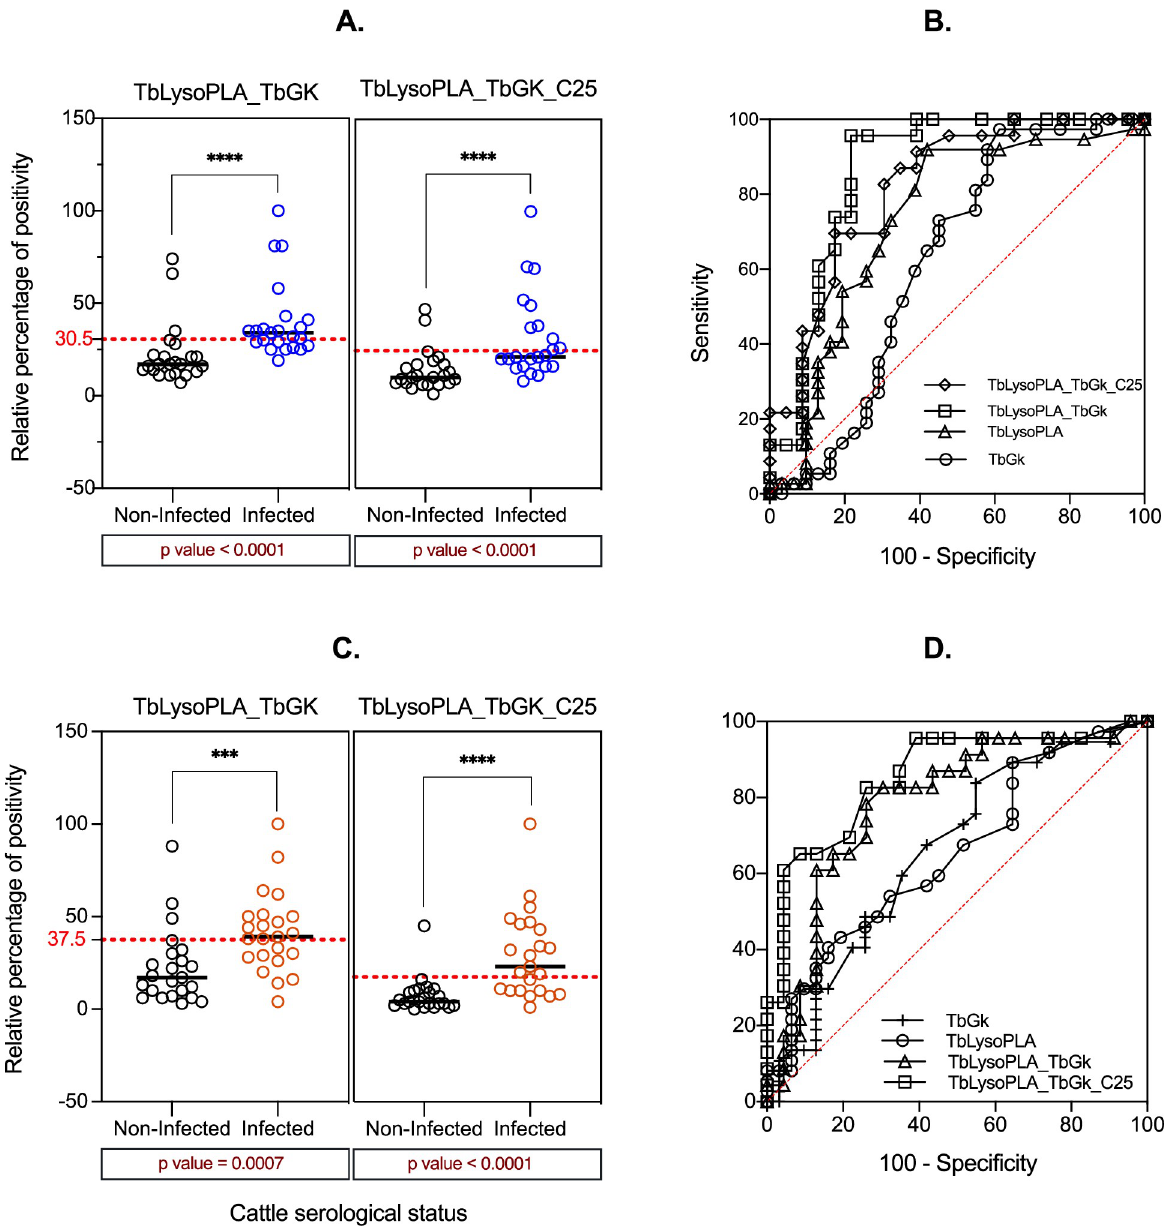
Fig 4. Protein equimolar mixtures as antigen in Ab-ELISA and ROC curve comparison between individual proteins and mixtures. (A.) bovine sera from T. congolense experimental infection (37 positive and 31 negative sera). (B.) ROC curve of antigens tested with experimental sera: TbLysoPLA (triangle), TbGK (dot), TbLysoPLA_TbGK (square) and TbLysoPLA_TbGK_C25 (rhombus). (C.) field sera from T.b. brucei, T. congolense and T. vivax mixed infection (37 positives and 31 negatives sera). (D.) ROC curve of antigens tested with field sera (same legends as in B). The optimal cut-off value (in A and C) for each antigen is shown in red dashed line. The global diagnostic performance was defined by AUC